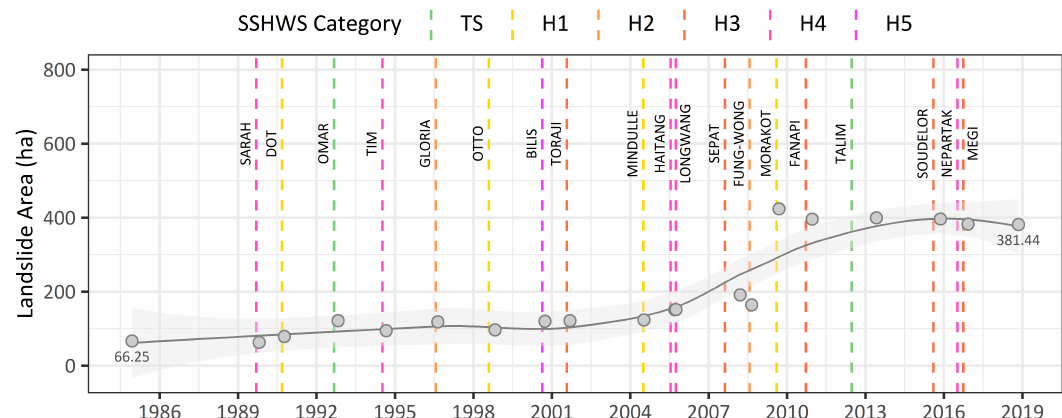
Figure 5. Time series of the Butangbunasi landslide area evolution and the dates of each typhoon event. The SSHWS category corresponds to the maximum category reached by the typhoon when crossing Taiwan. The mapped areas for the images corresponding to 12 December 1984 and 8 November 2018 are indicated. A locally estimated scatterplot smoothing (LOESS) curve (confidence interval 95%) is fitted to the time series for illustration purposes.